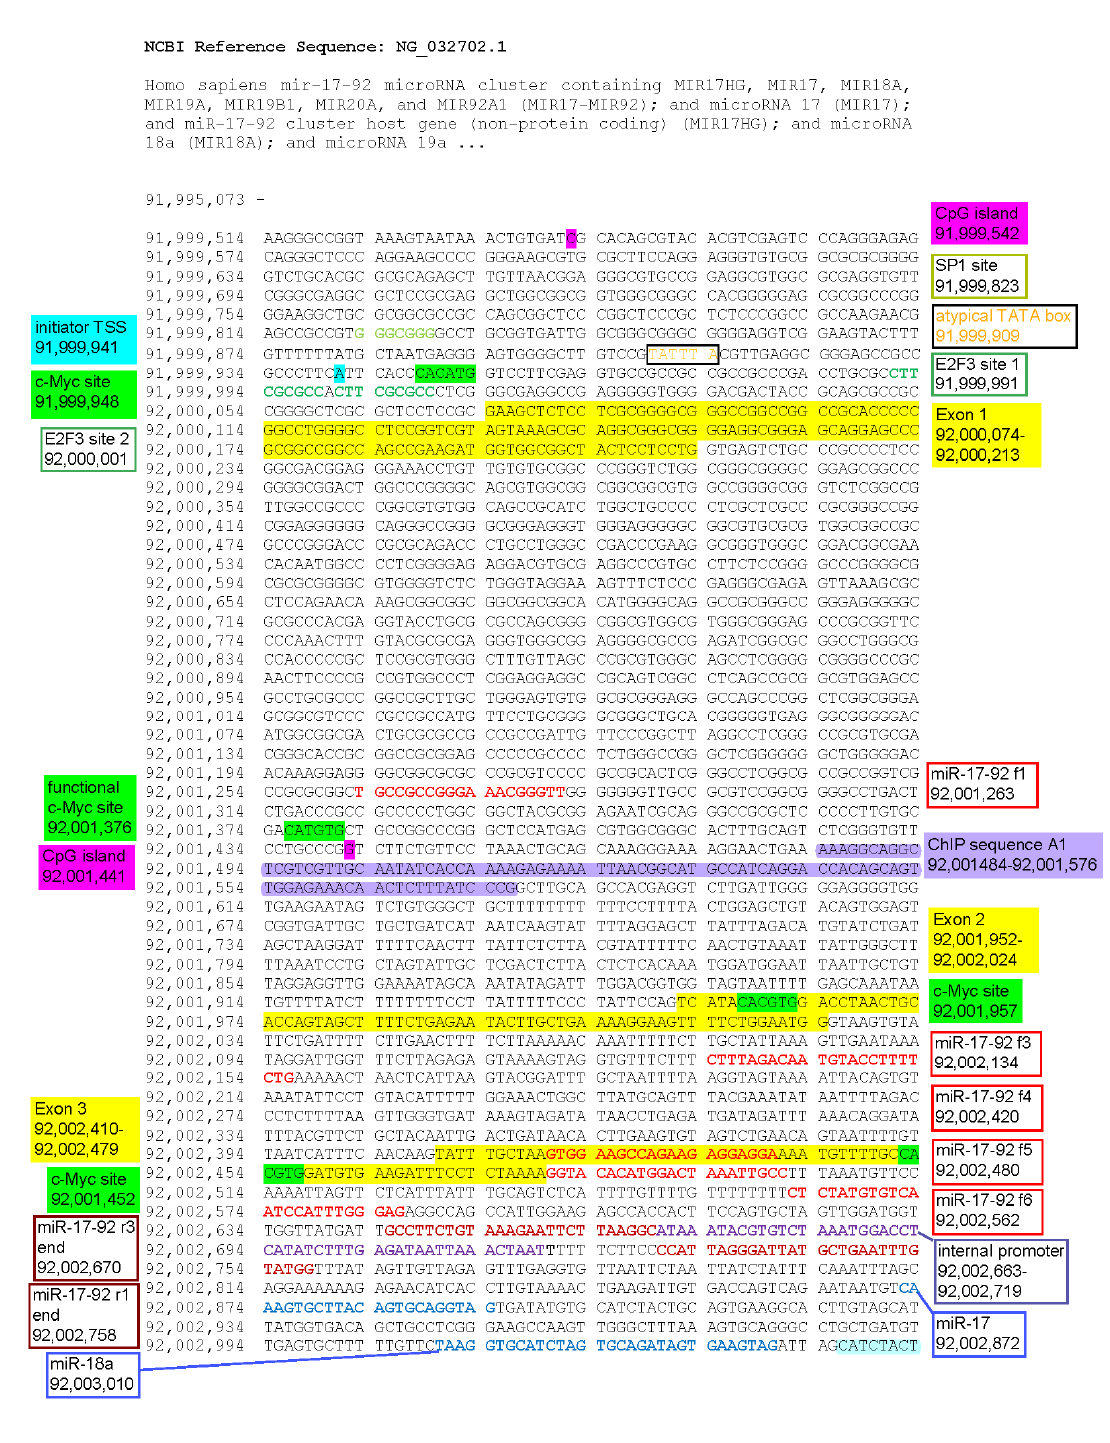
Figure S1. Relevant sequence region of C13 orf 25, including the CpG island harboring the host gene promoter, the A/T-rich region, and the miR-17-92 cluster; sequence and position of the last exon 4 of C13 orf 25 is indicated at the end. Shown sequences are based on the NCBI reference sequence NG_032702.1 and the GRCh37/hg19 assembly [25]. The boundaries of the CpG island, important previously identified regulatory elements, mature miRNA coding sequences and relevant primer sequences are highlighted in the sequence and annotated at the